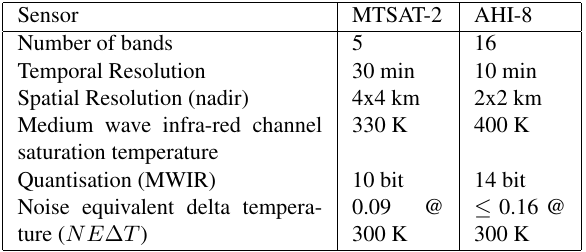
Table 1: Comparison of MTSAT-2 and AHI-8 sensors for